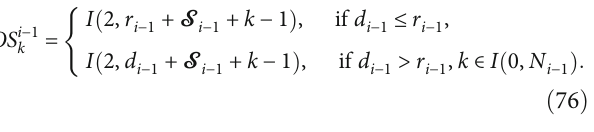
ð ̂ m , k Þ , δ 1,1 k